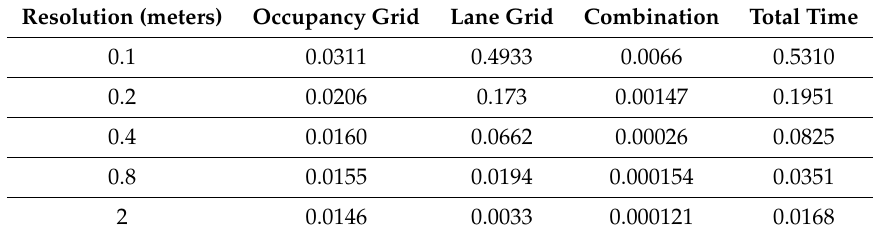
Table 1. Average execution time in seconds used by each procedure in the evidential grid construction. The grid size was set at (40 × 16) m. Tested on PC of processor Inter(R) Core(TM) i7, CPU @ 2.30GHz. RAM